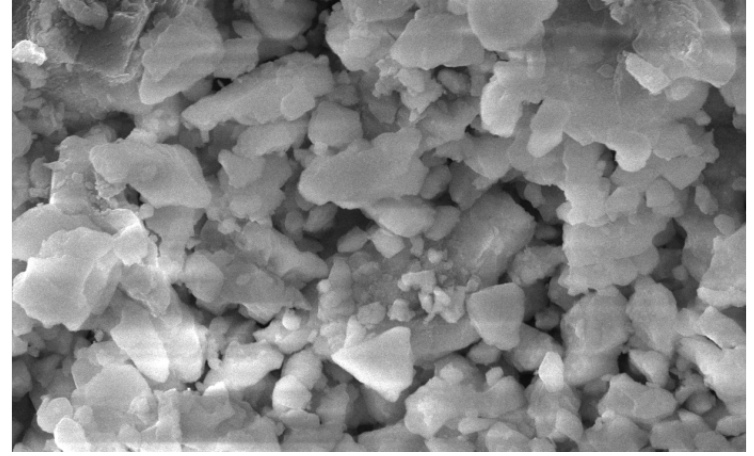
Figure 4. SEM micrographs of marble sludge.